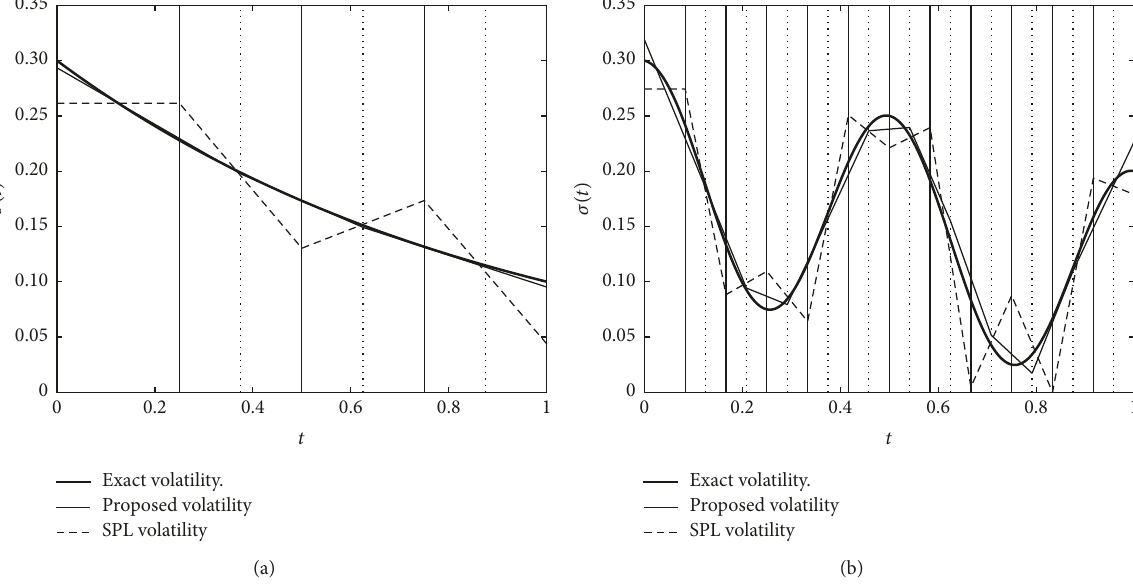
Figure 6: Construction of volatility by the SPL and proposed algorithms when the exact volatility is (a) 𝜎(𝑡) = 0.3/3 𝑡 and (b) 𝜎(𝑡) = 0.1 cos (4𝜋𝑡) − 0.1𝑡 + 0.2